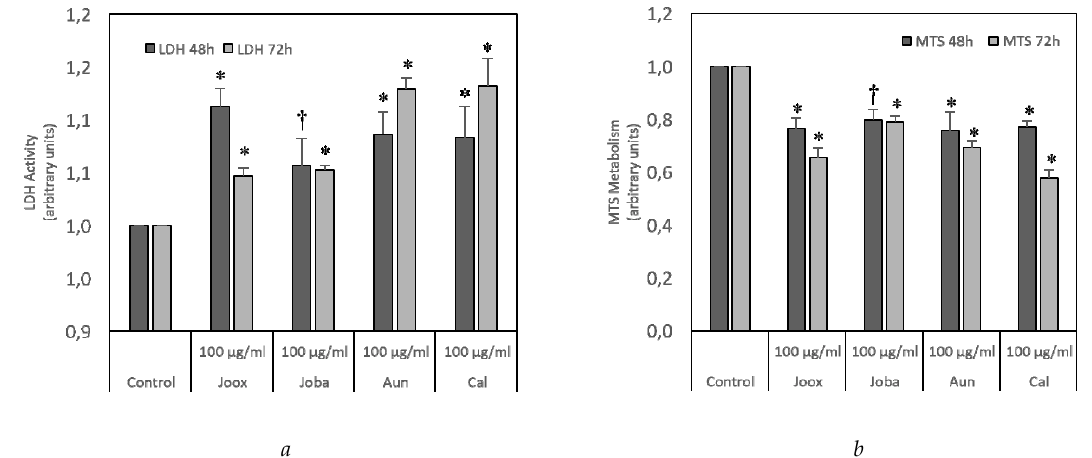
Figure 1. Screening of antitumor activity. HT29 cells were exposed to 100 µ g / mL of total protein extract from Juniperus oxycedrus subsp. oxycedrus (Joox), Juniperus oxycedrus subsp. badia (Joba), Arbutus unedo (Aun) and Corema album (Cal), for 48 and 72 h. Saline containing 2 mM CaCl 2 and 2 mM MgCl 2 was used as control. General cell death ( a ) and cell viability ( b ) were evaluated by LDH release and MTS metabolism assays, respectively. Results are expressed as mean ± SEM fold-change to control from three independent experiments. * p < 0.01 and † < 0.05 for HT29 cells.